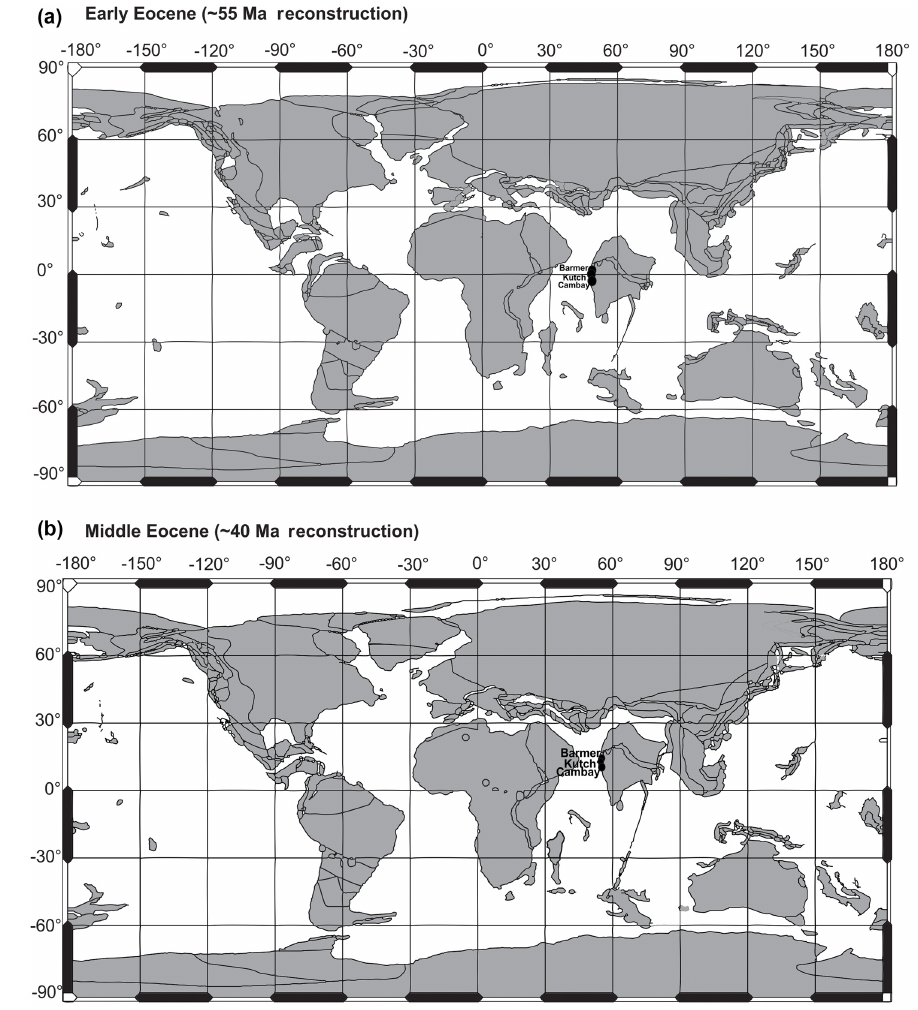
Figure 1. Paleoposition of the Cambay, Kutch and Barmer basins in India during the (a) Early Eocene and (b) Middle Eocene.